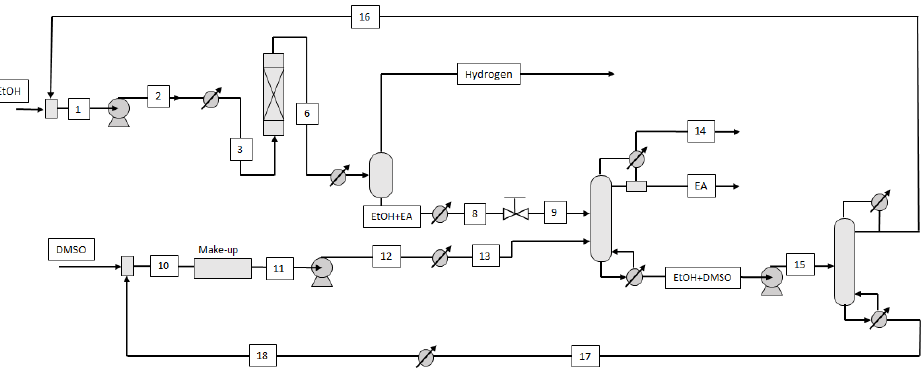
Figure 7. Scheme of an industrial plant of ethanol dehydrogenation to ethyl acetate. Plant capacity was calibrated for producing 1665 tons/y of hydrogen with an ethanol feed of 38,700 tons/y. Re-elaborated from [16] and reported with the permission of Elsevier.